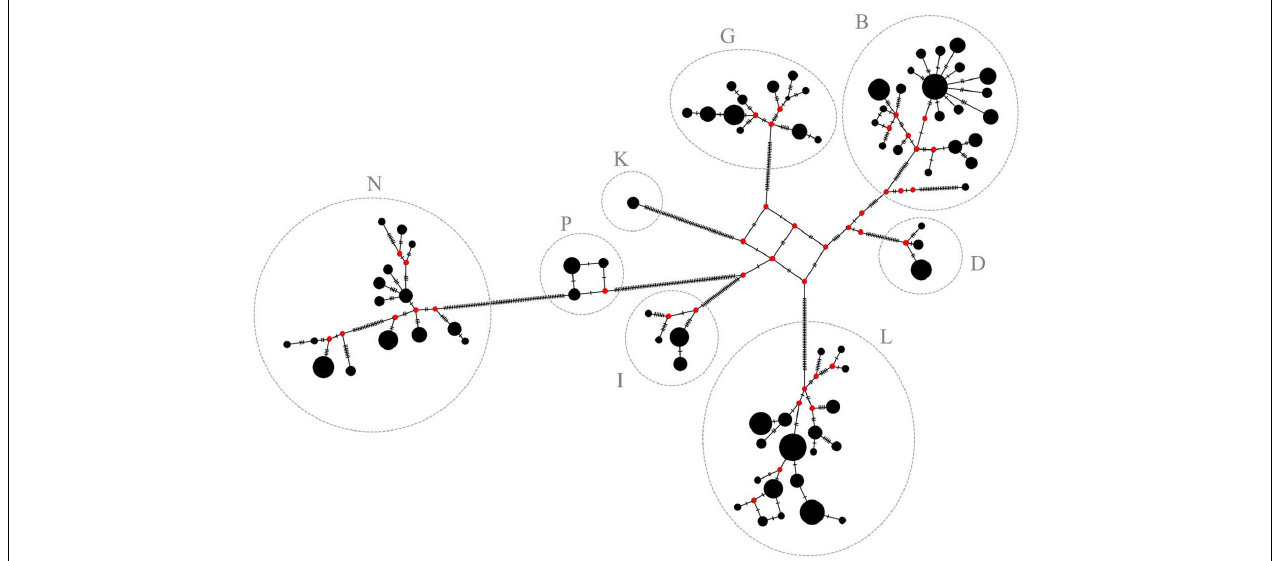
FIGURE 4 | Median-joining network of the 78 haplotypes. Haplotypes are represented by black circles. Size of the circles is proportional to the haplotype frequency. Red circles (median vectors) illustrate missing haplotypes. Haplogroups are assigned according to Achilli et al. (2012) and are in accordance with previous results of this study (see Figure 3 for